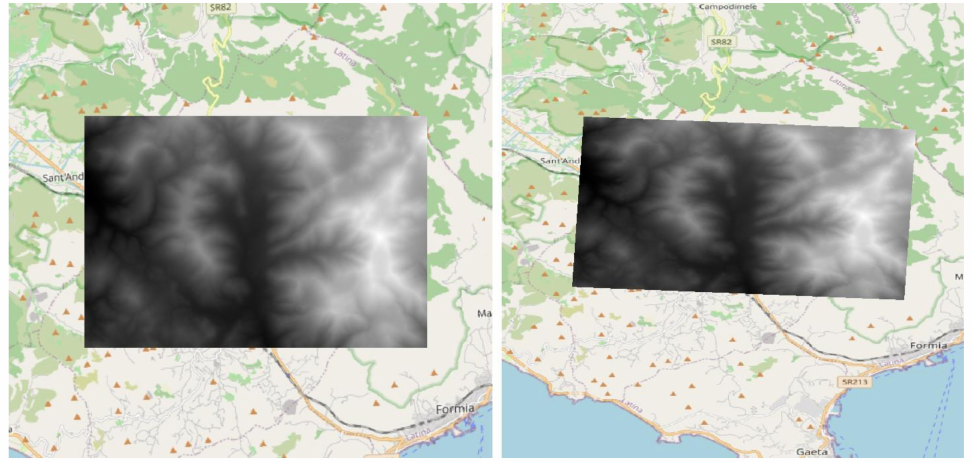
Figure 4. Raster image represented by two different